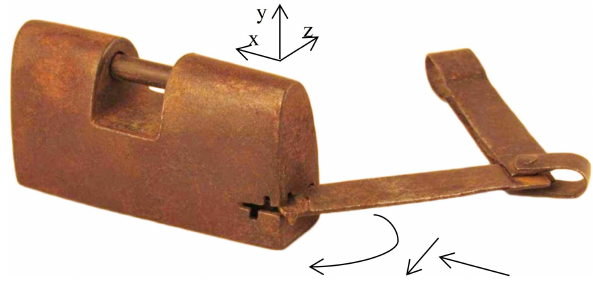
Figure 3. Padlock without direct insertion of the key (Yi Zhi Tang